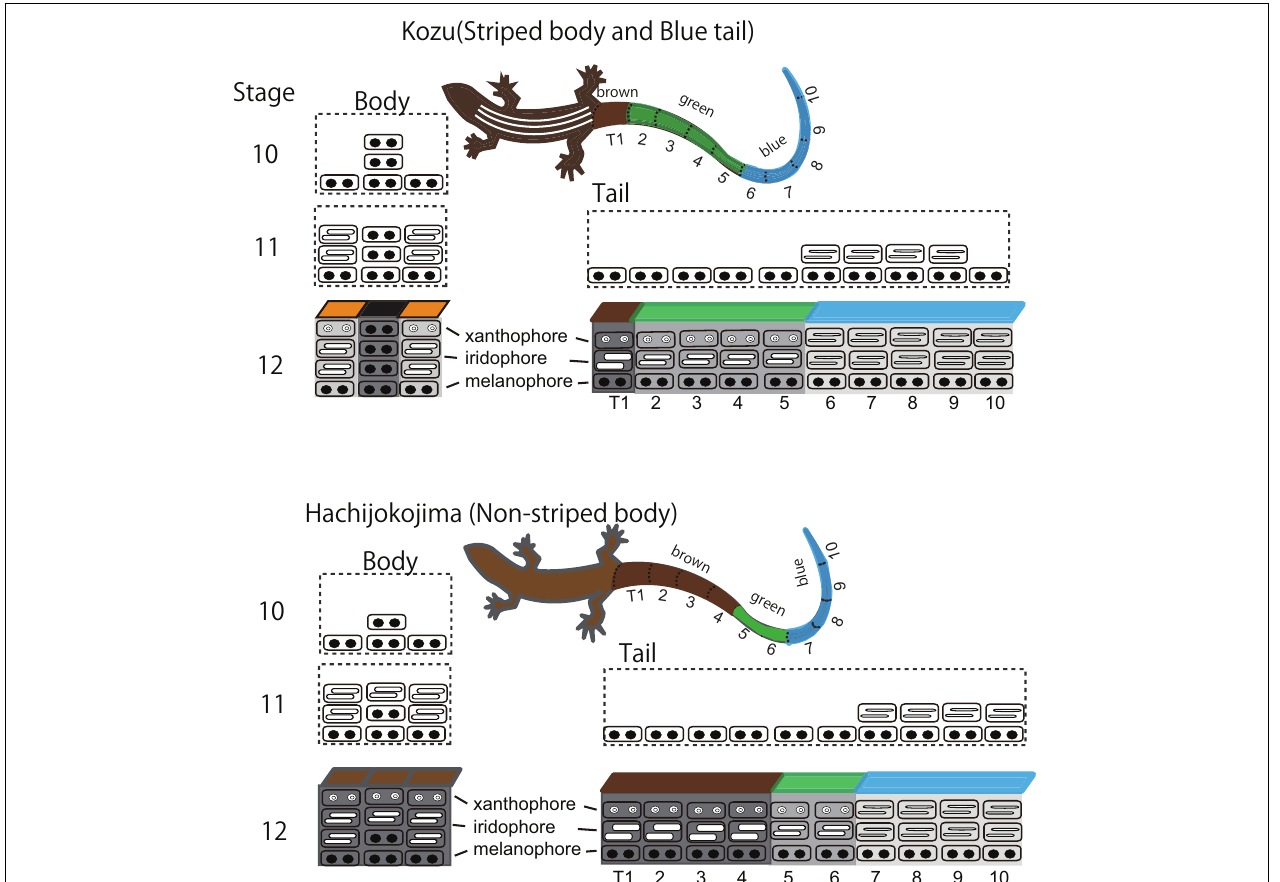
FIGURE 4 | A schematic drawing of stripe pattern and tail color formation during embryogenesis in Plestiodon latiscutatus. The melanophore density in the black background region was higher in lizards with vivid stripes in Kozu island of Japan than in lizards with drab stripes in Hachijokojima island. Iridophores started to fill the dermal space that was not yet occupied by melanophores, which resulted in a higher iridophore density in stripes than in the inter-stripe regions. Iridophores with thin platelets reflecting blue structural coloration appeared at a specific region in the tail at stage 11. The position of the tail where iridophores emerged coincided with the boundary area separating anterior brown and green colored tail from posterior blue colored tail after hatching. Figure from Kuriyama and Hasegawa (2017) with permissions.